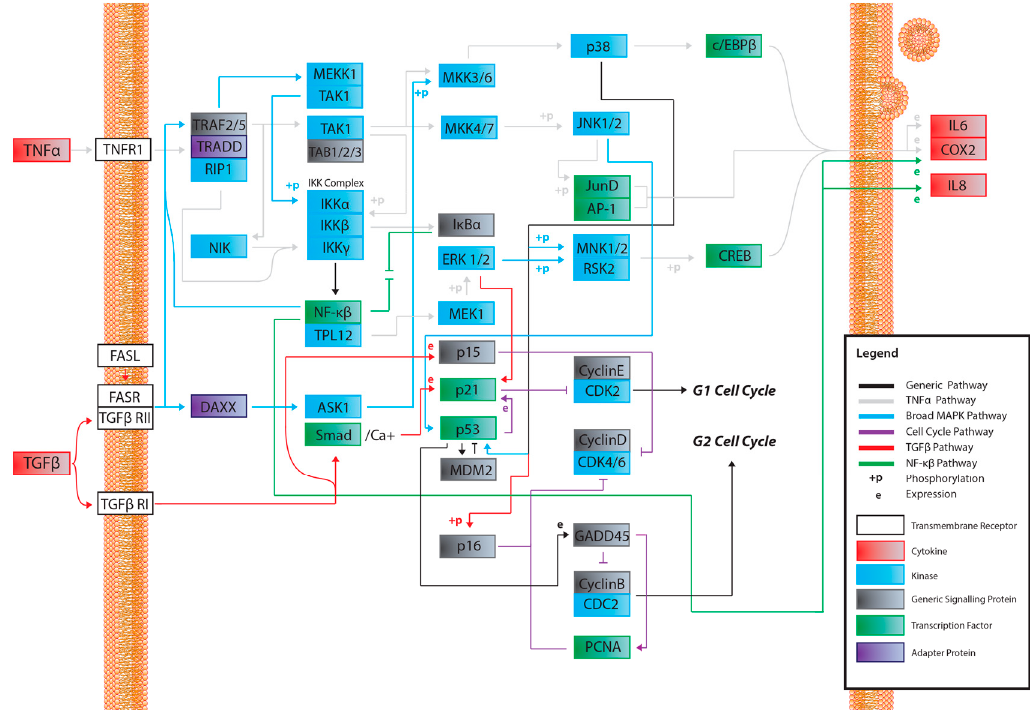
Figure 1. A map of potential pathways and their potential interactions activated by a soluble factor- radiation-induced bystander effect (RIBE) signal. While not entirely inclusive, this map was constructed to be displayed as a working reference point for current and future research. The pathways outlined in the legend have been identified as candidates for RIBE-intracellular and extracellular signalling. The following Figures 2–5 are entirely derivative of this one and attempt to more closely showcase potential signalling within each pathway. Black lines or “generic pathways” represent interactions belonging to the other four pathways that could not be specified in this figure for clarity.